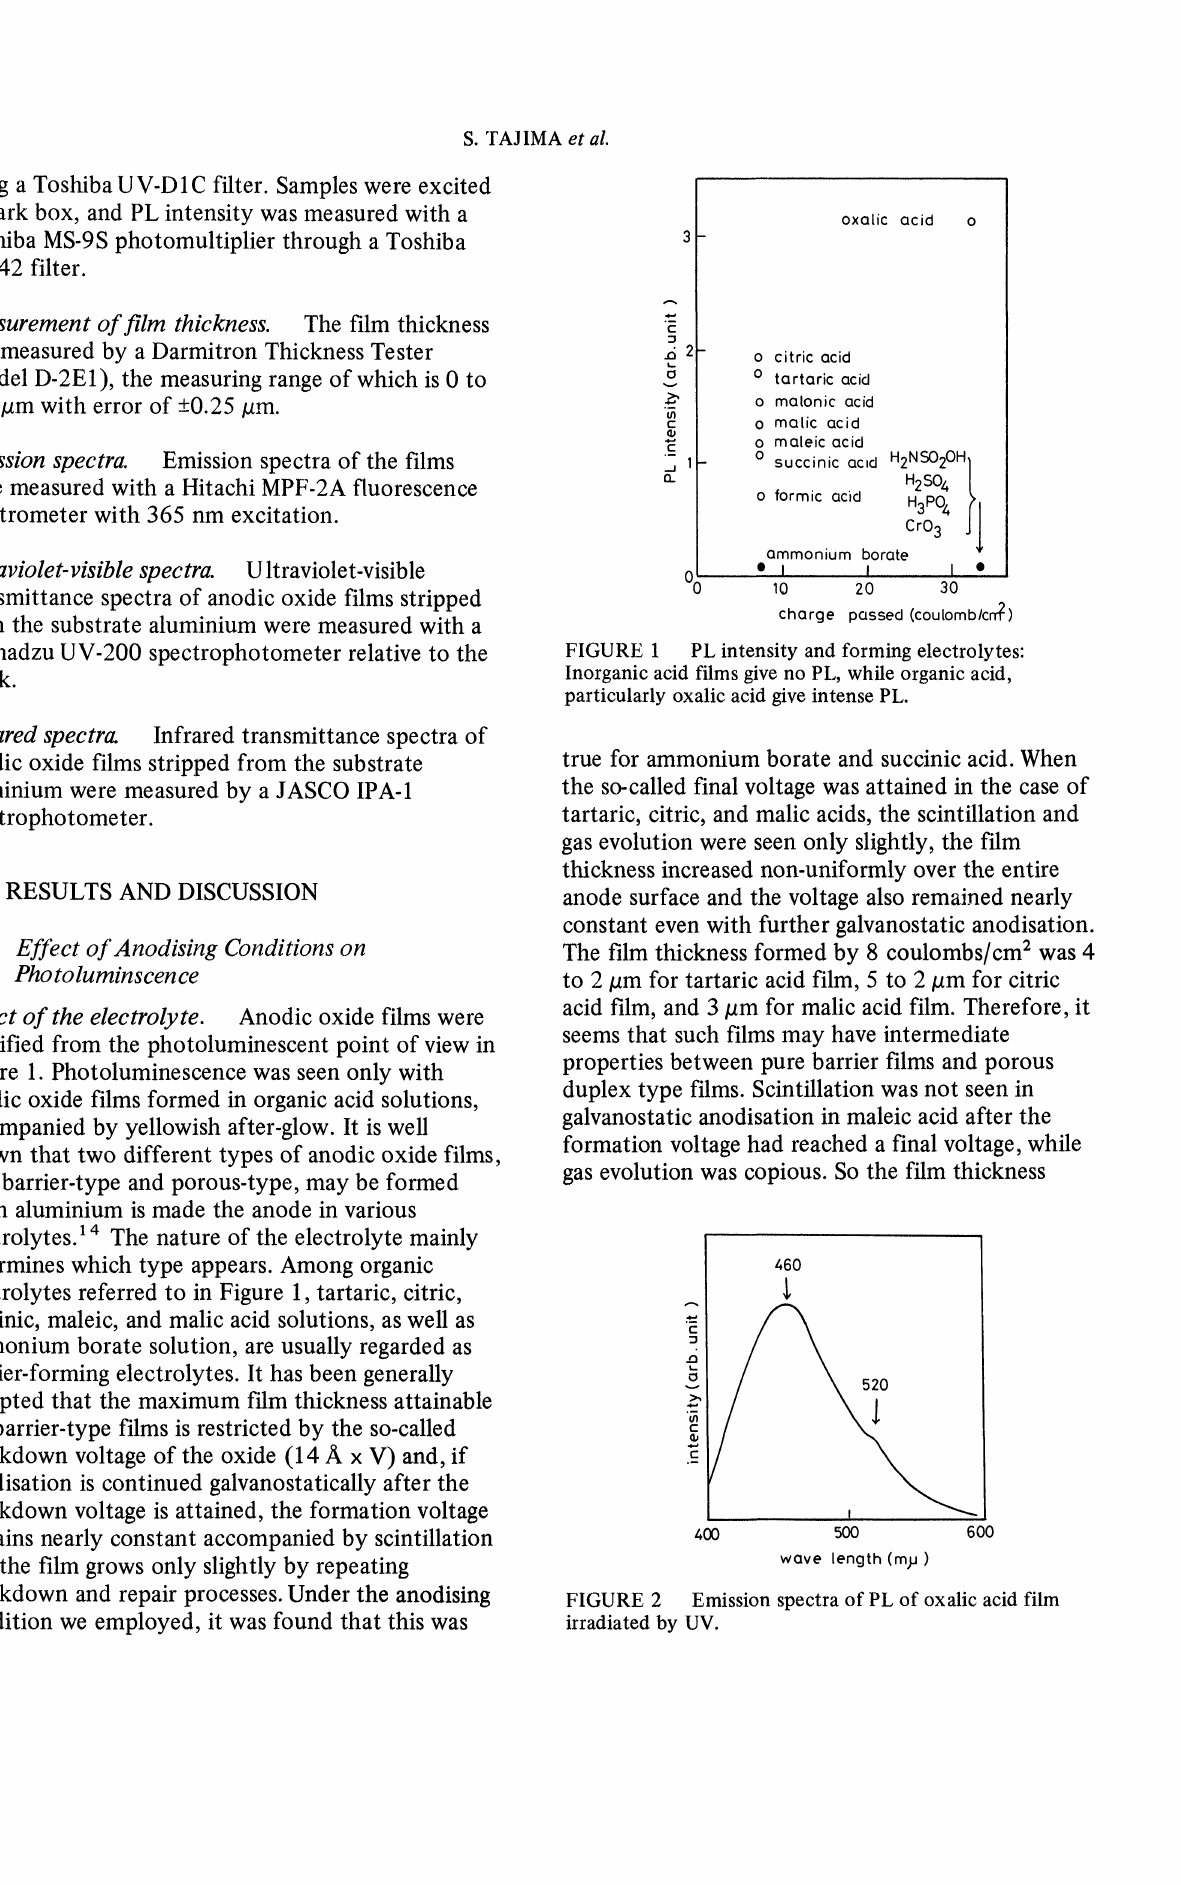
PL intensity and forming electrolytes: Inorganic acid films give no PL, while organic acid, particularly oxalic acid give intense PL.